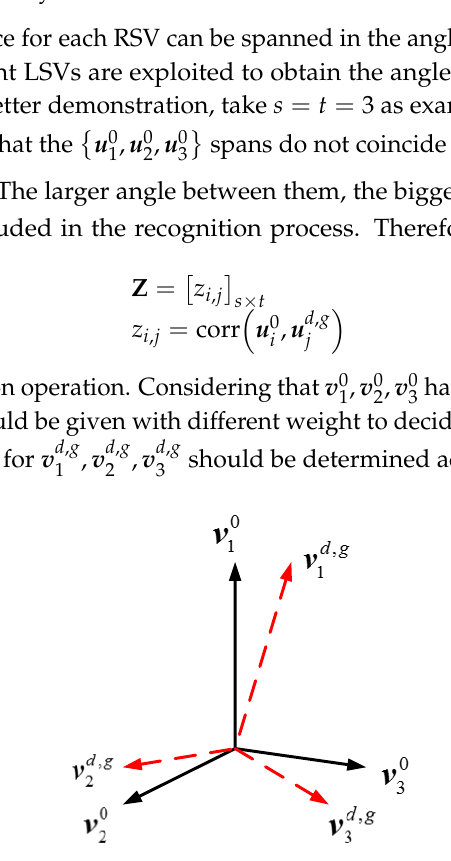
Figure 4. The angle between the spaces that the training and test data spans.